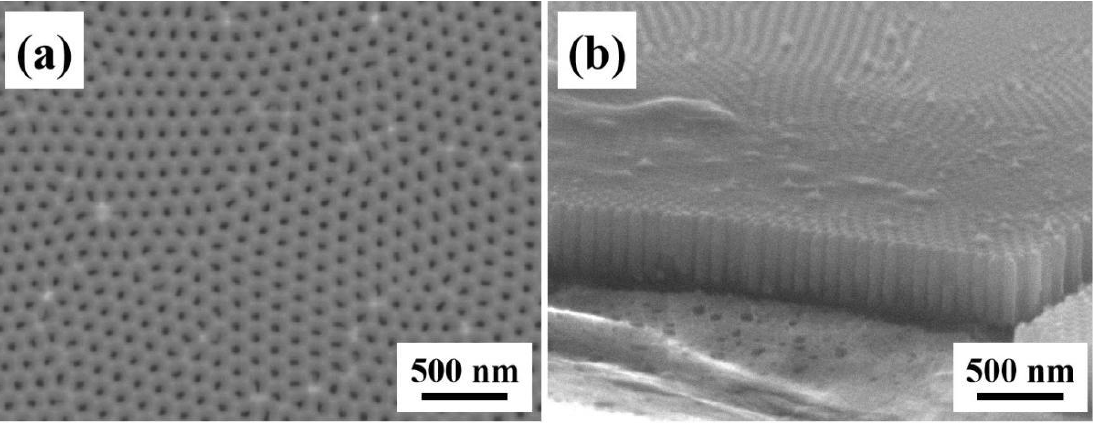
Figure 3. FE-SEM images of the prepared AAO nanoarrays from ( a ) top view and ( b ) cross-section view.